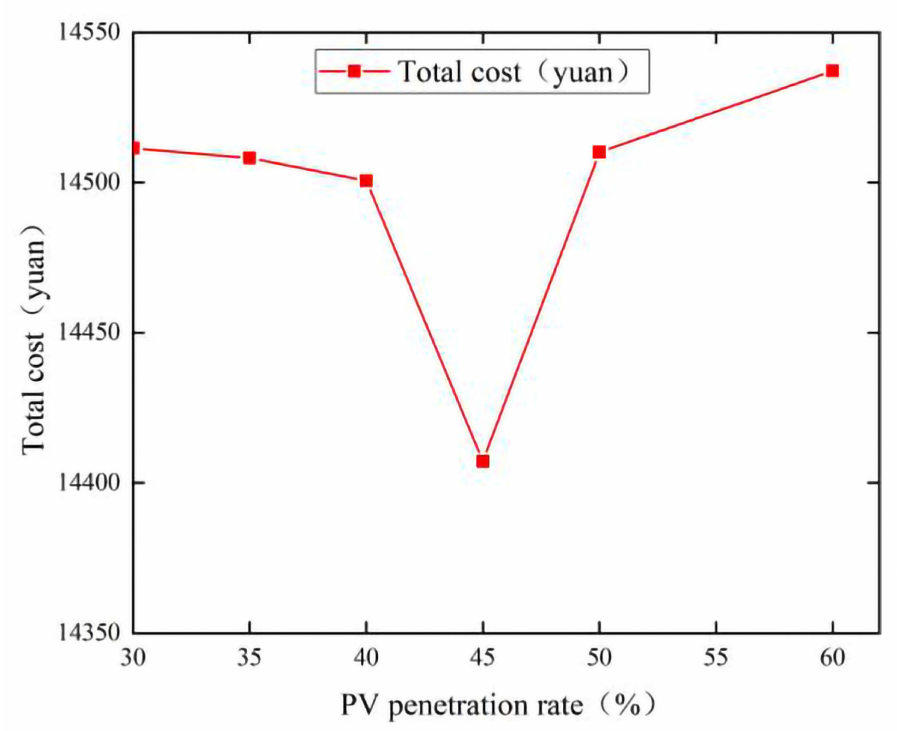
Figure 15. Total cost curve under different PV penetration rates.